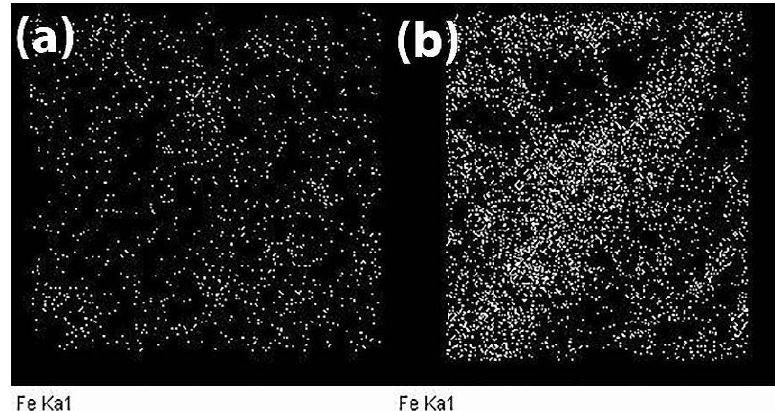
Fig. 12. Elemental mapping of Fe a) before regeneration process (UMFS), and b) after the regeneration process (RMFS).